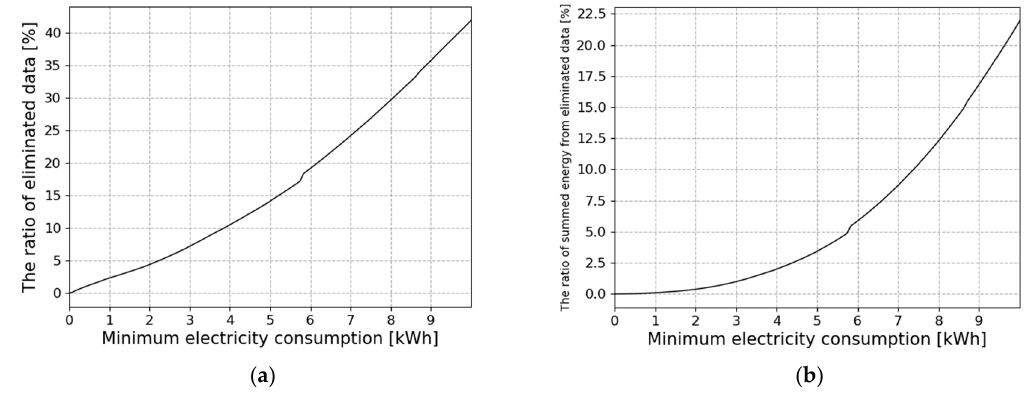
Figure 9. Graphs represent the effects of eliminated data. ( a ) The ratio of eliminated data to total data and ( b ) the ratio of summed energy of the eliminated data to that of total data in a relation to minimum electricity consumption value.